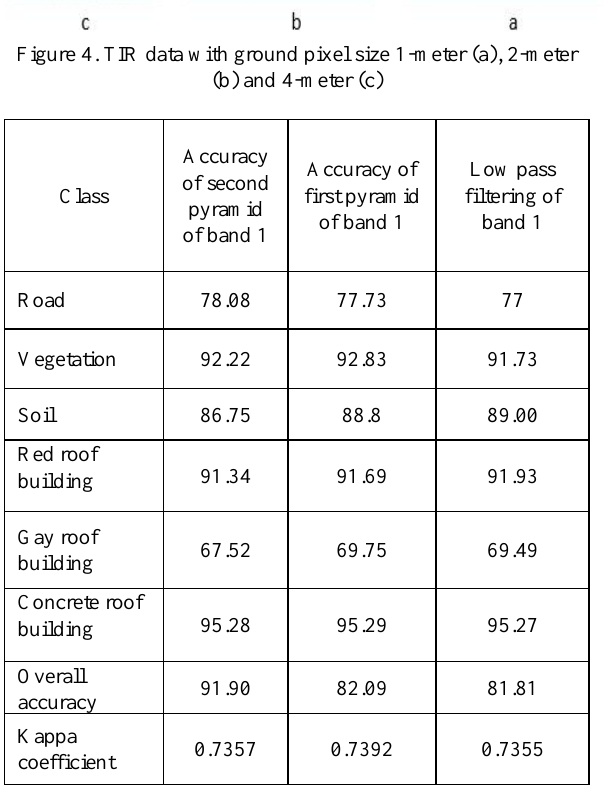
Table 1. Accuracies of the applied pyramids and low-pass filter on the first selected band of the data set